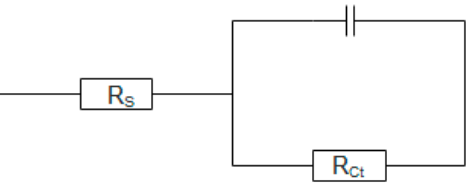
Figure 8. Equivalent circuit of the measured impedance spectra.